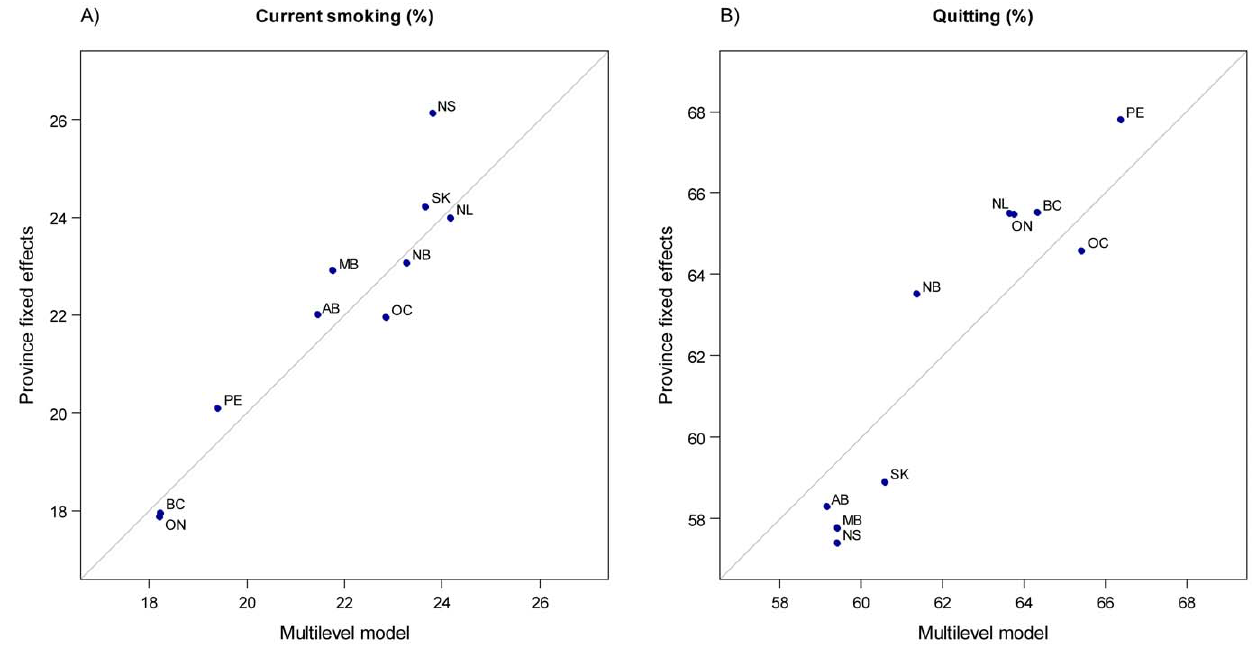
Figure 4. Comparison of adjusted prevalence estimates for current smoking and quitting for Canadian provinces based on mutually adjusted fixed effects and multilevel logistic regression models. Province name abbreviations: AB Alberta; BC British Columbia; MB Manitoba; NB New Brunswick; NL Newfoundland; NS Nova Scotia; ON Ontario; PE Prince Edward Island; QC Quebec; SK Saskatchewan.